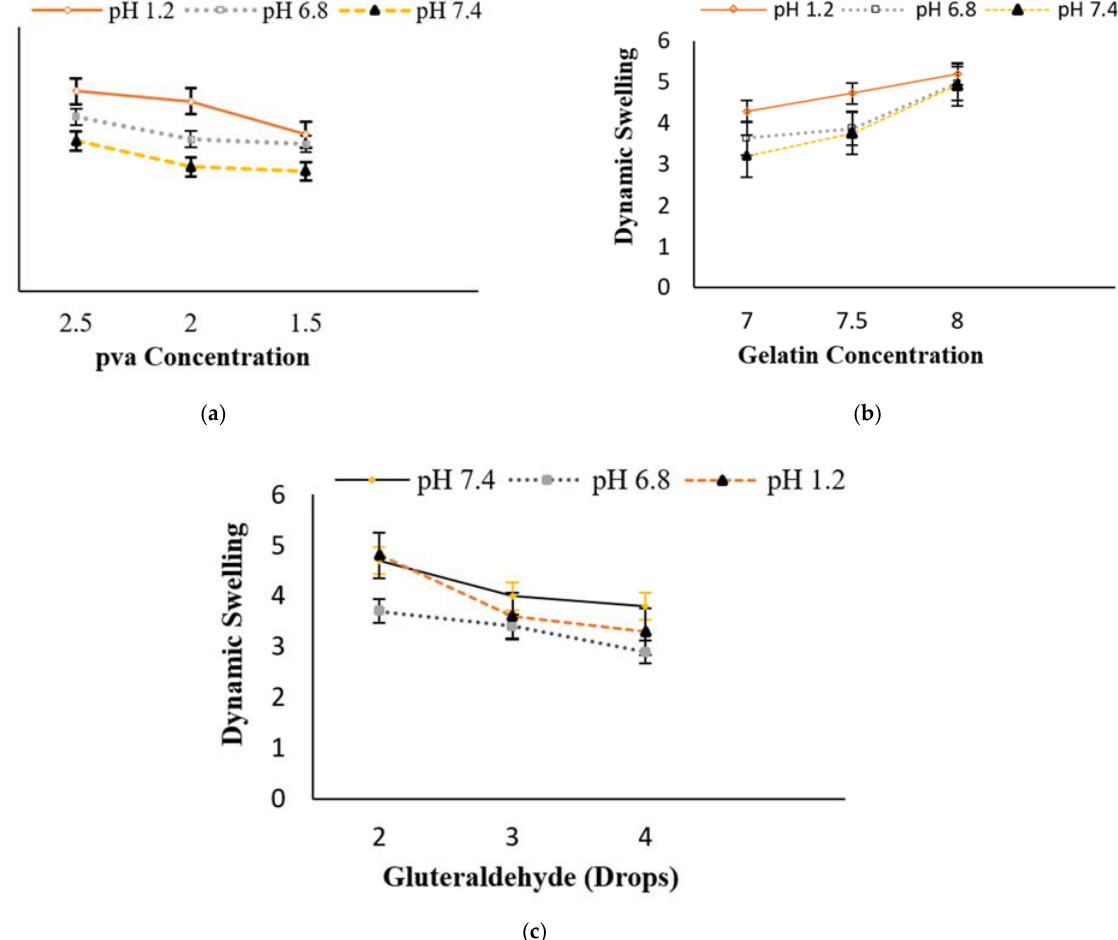
Figure 1. Dynamic swelling of Gel/PVA hydrogel with ( a ) decreasing concentration of PVA, ( b ) increasing concentration of Gel and ( c ) increasing quantity of glutaraldehyde. Data are expressed as mean ± S.D. and p < 0.01 is considered statistically significant.